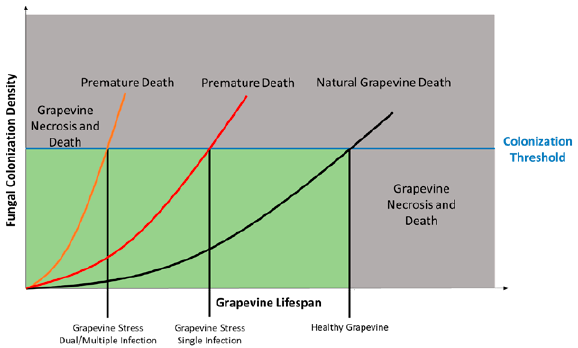
ing the relationship between the grapevine age and GTD fungal col- onization density. Under normal conditions, fungal growth is slow, only reaching the colonization threshold in old grapevines during natural senescence. Under stress conditions, fungal growth is accel- erated, and this threshold is reached rapidly in the grapevine lifes- pan, leading to disease progression and premature host death. This threshold is hypothesized to be reached sooner when multiple GTD fungi are present than when few fungi occur (adapted with permis- sion from Sieber,